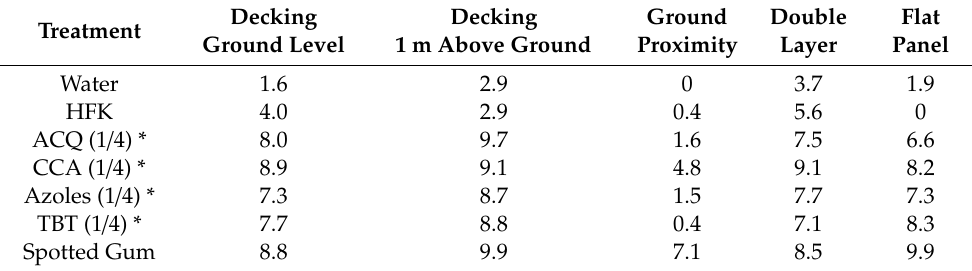
Table 2. Decay Ratings after 10 years exposure at Whakarewarewa, Rotorua.